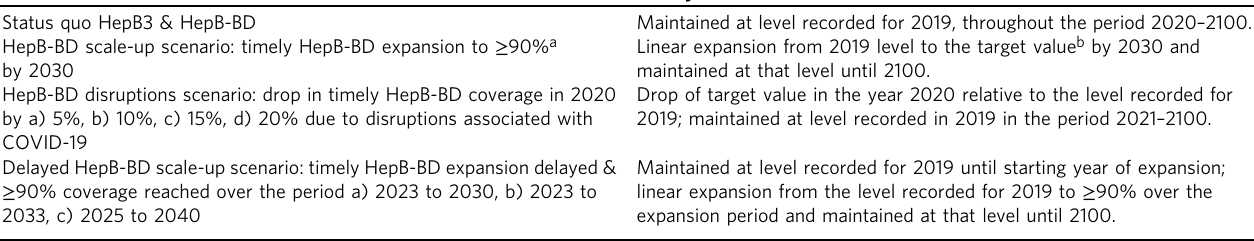
Table 1 Vaccination scenarios. Scenario Timely birth dose vaccination Status quo HepB3 & HepB-BD